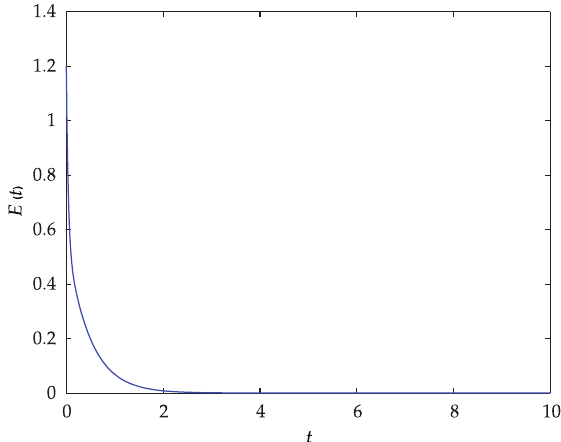
Figure 2: Time evolution of the lag synchronization errors E (cid:4) t (cid:5)